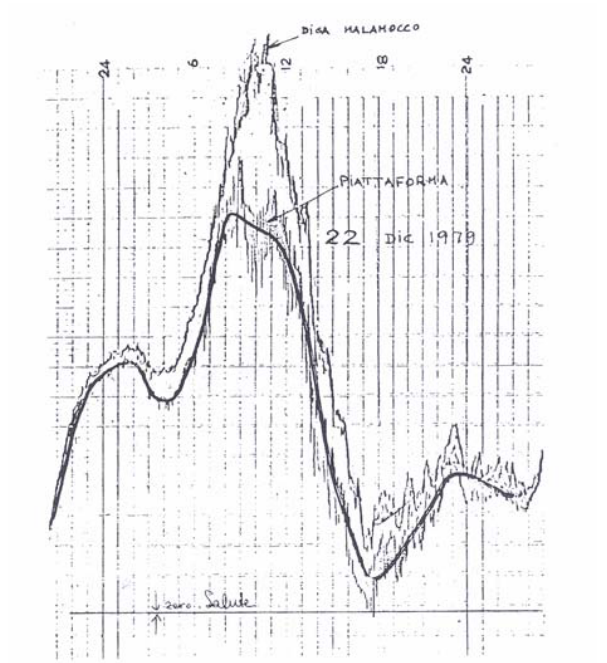
Fig. 14. The tidal record of 22 December 1979 at the tower (thick line – see Fig. 2) and at the end of one of the jetties bordering the inlets to the lagoon (see Fig. 13). The horizontal spacing is one hour, the vertical one 10cm (after Cavaleri, 1999).